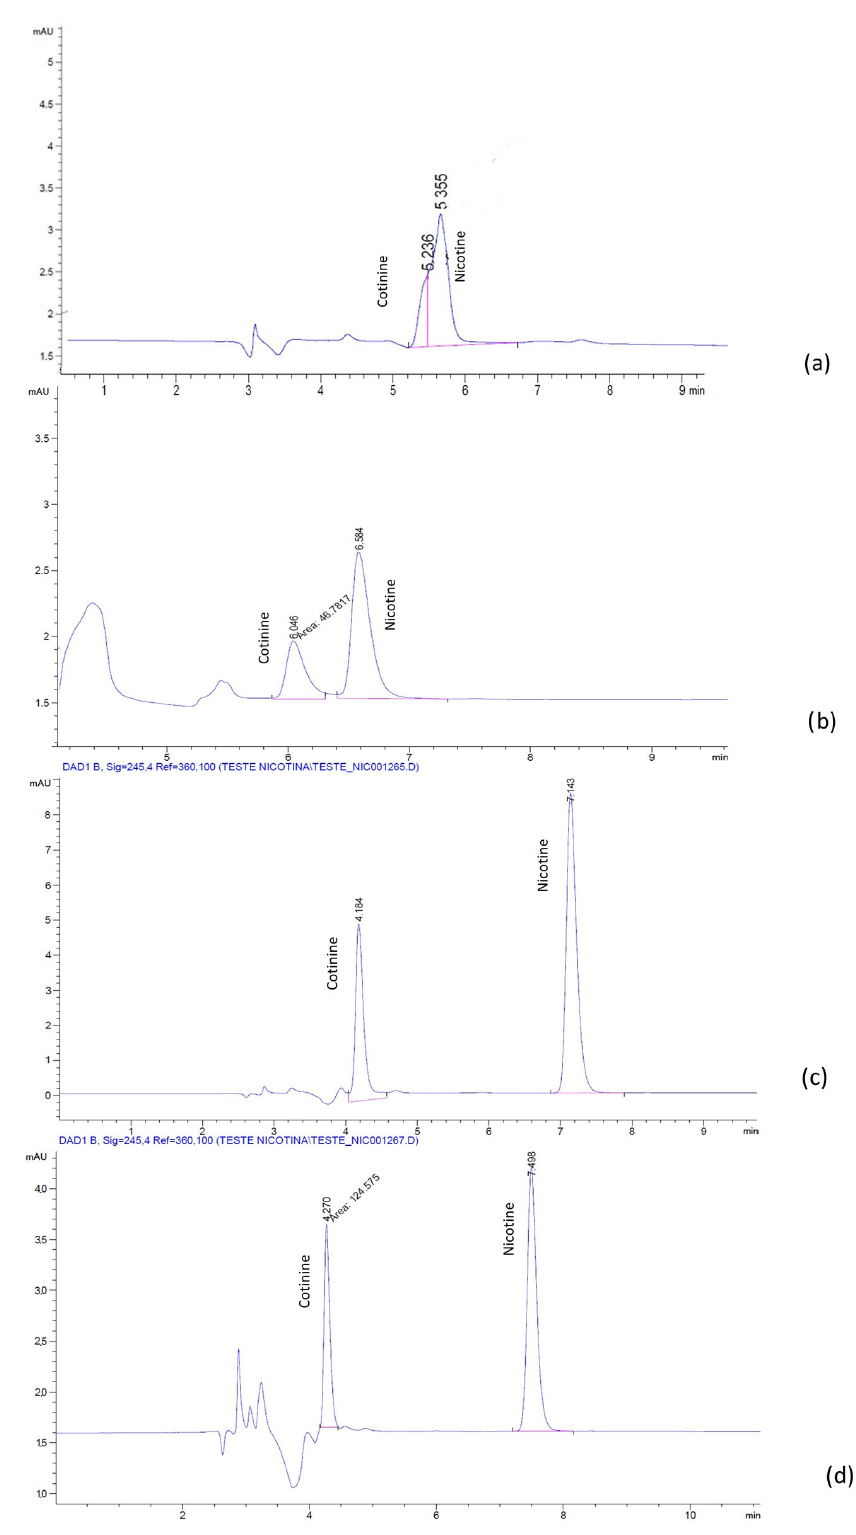
Figure 3. Chromatograms of nicotine and cotinine in human plasma with mobile phases containing phosphate buffer:ACN 60:40 (pH 2.3 with H 3 PO 4 ): ( a ) without additive; ( b ) with 0.5 mM BMIM[BF 4 ]; ( c ) with 1.0 mM BMIM[BF 4 ]; ( d ) with 2.5 mM BMIM[BF 4